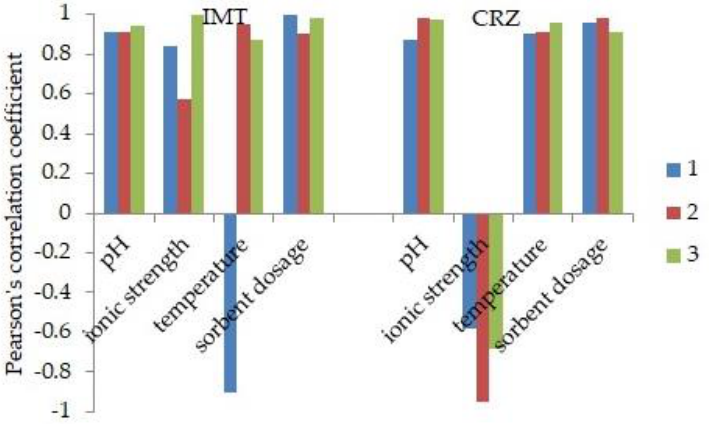
Figure 5. Determination of Pearson’s correlation coefficients between sorption influencing parame- ters.